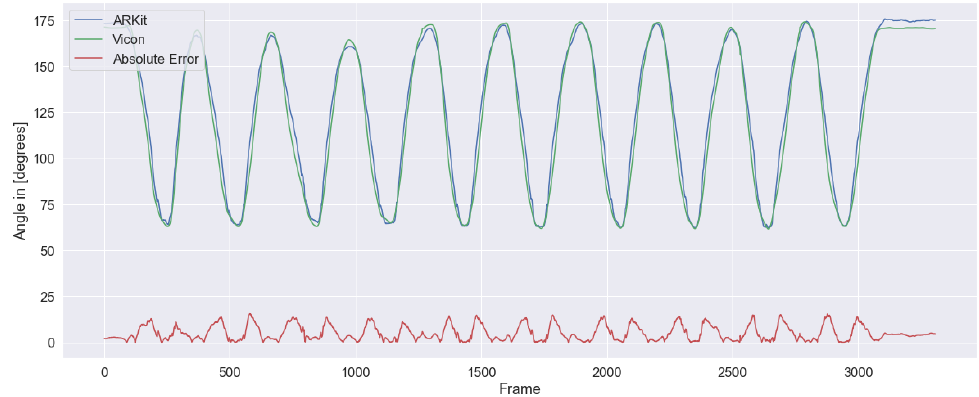
Figure 6. Left hip angle of one of the subjects in the Single Leg Deadlift exercise in degrees, which shows a nearly perfectly overlapping curves of the ARKit and Vicon data.